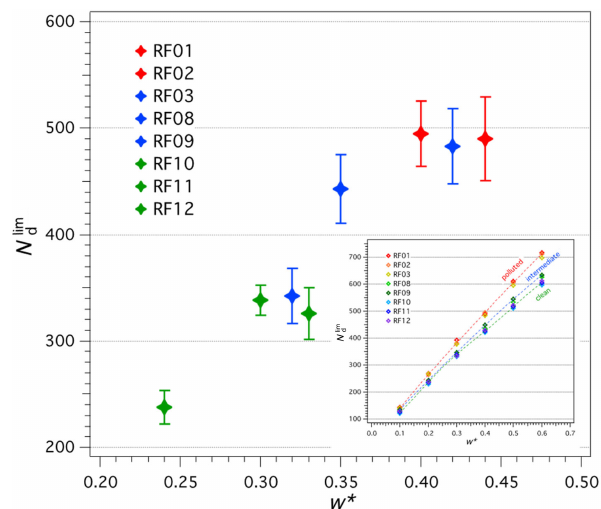
Figure 6. N lim (cm − 3 ) for each flight as a function of characteris- d tic vertical updraft velocity, w ∗ (ms − 1 ). Flights are colored by pol- luted, intermediate, and clean categories, as defined by MBL con- centration. The inset also presents the asymptotic activated droplet number ( N lim ; cm − 3 ) for w ∗ ranging from 0.1 to 0.6ms − 1 d